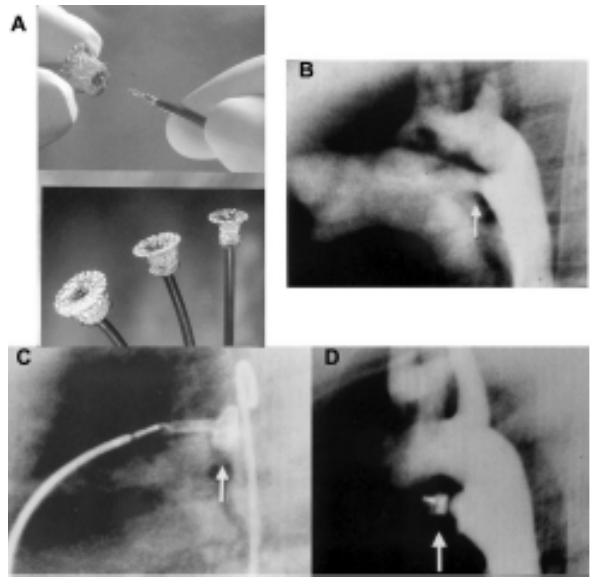
Fig. 3 - Example of arterial duct occlusion using the Amplatzer occlusion system. A) Shows the device and its release cable. B) Aortogram showing an extensive arterial duct (arrow). C) Amplatzer prosthesis being manipulated by the release cable to adjust its position (arrow). D) Aortogram showing total occlusion of the duct after release of the device